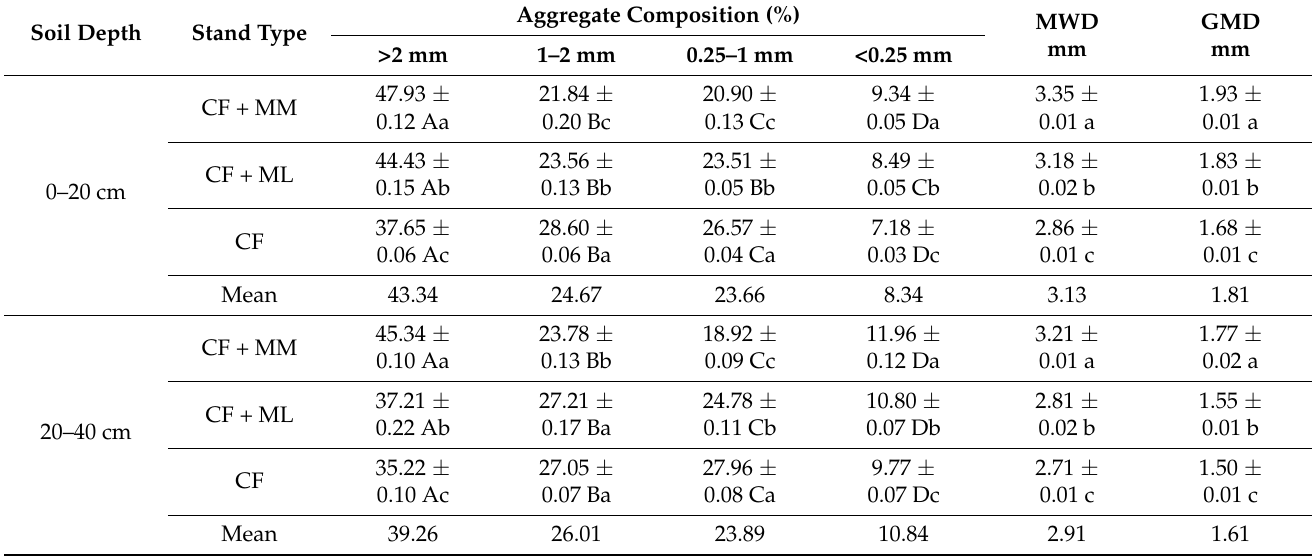
Table 3. Distribution and stability of soil aggregates as influenced by stand type in Chinese fir